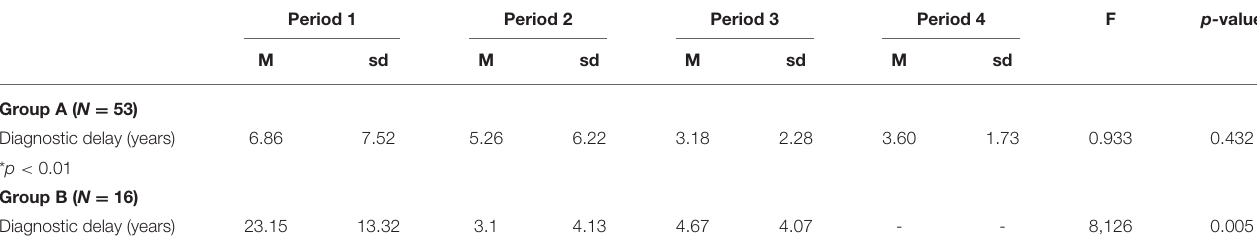
TABLE 5 | Differences between Group A and Group B in terms of diagnostic delay and temporal periods in which the molecular genetic diagnosis was made.